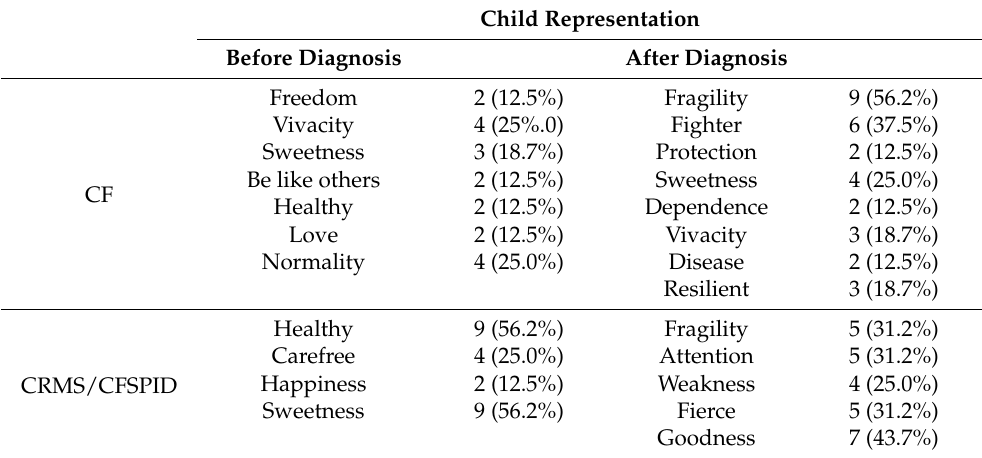
Table 5. Child representation before and after CF and CRMS/CFSPID diagnosis.